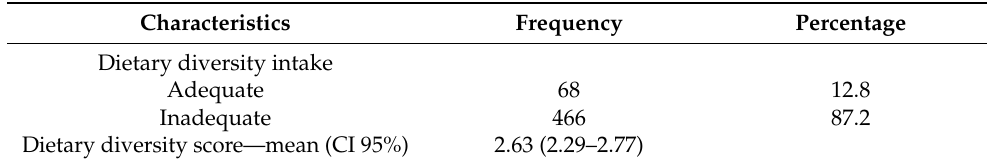
Table A1. Dietary diversity intake in the last 24 h by Ghanaian children aged 24–59 months, GDHS-14 ( N = 534).